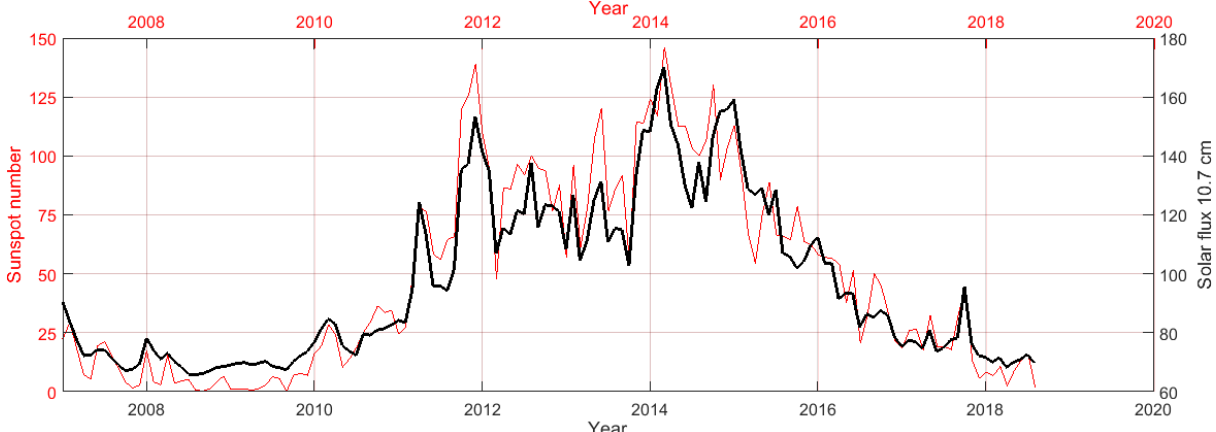
Figure 2. Display the variations in the sunspot numbers and solar flux for the year 2008 to